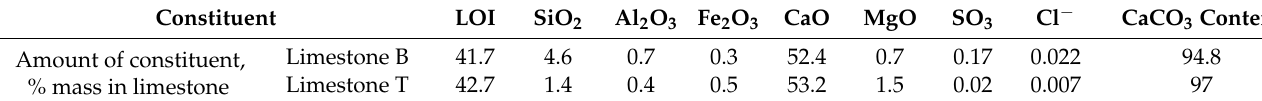
Table 4. Chemical composition of limestones used in the research.